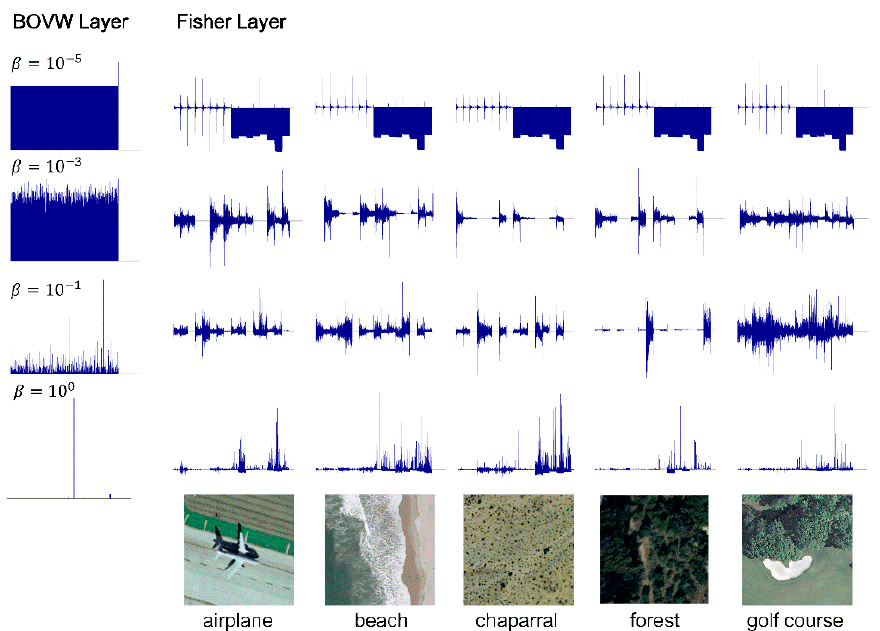
Figure 8. Visual coding result of the Hierarchical Coding Vector (HCV) of different parameters on the LU database. Each vertical column represents the coding result of a different β for the same image. Each horizontal row represents the coding result of same β for different images.